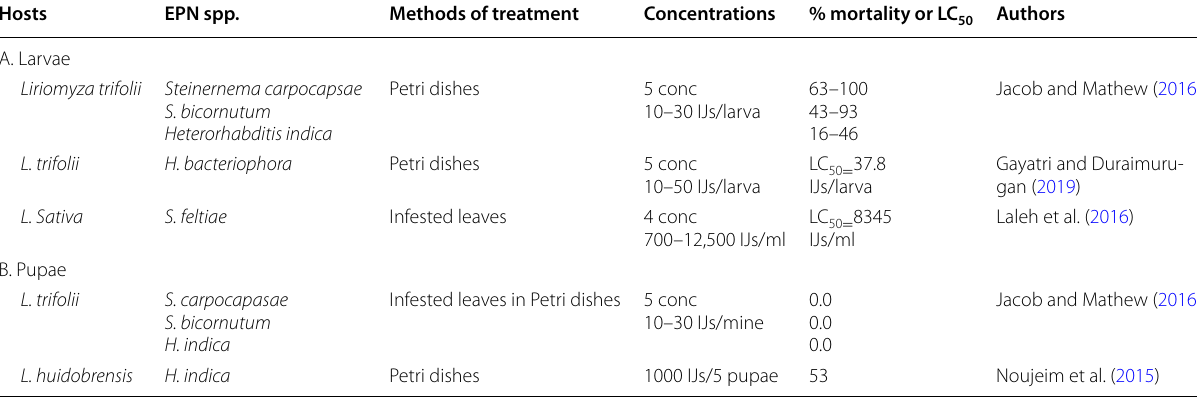
Table 1 Efficiency of entomopathogenic nematodes against leafminers Hosts EPN spp. Methods of